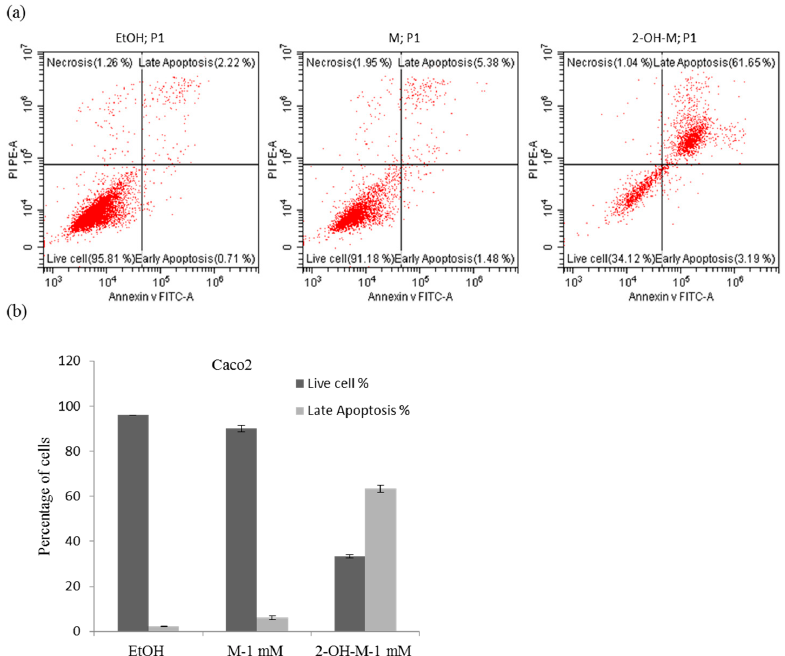
Figure 3. Induction of apoptosis in Caco2 cells by 2-hydroxymelatonin, as determined by staining